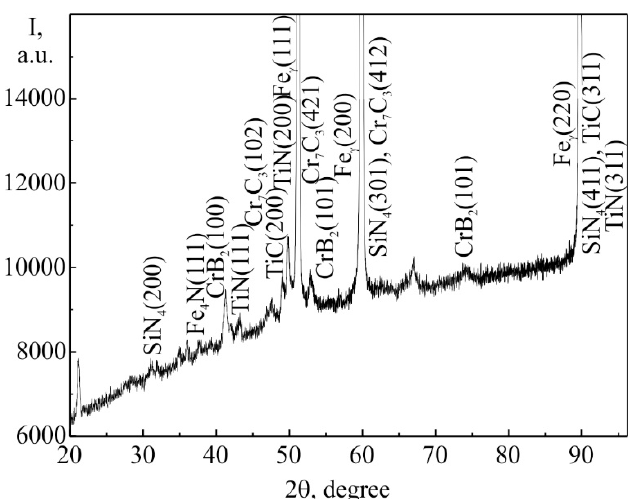
Figure 8. A diffraction pattern of the surface layer on AISI 304 steel laser alloyed with a plaster of 15Fe + 30Ni + 20B + 10Si + 25% liquid glass.